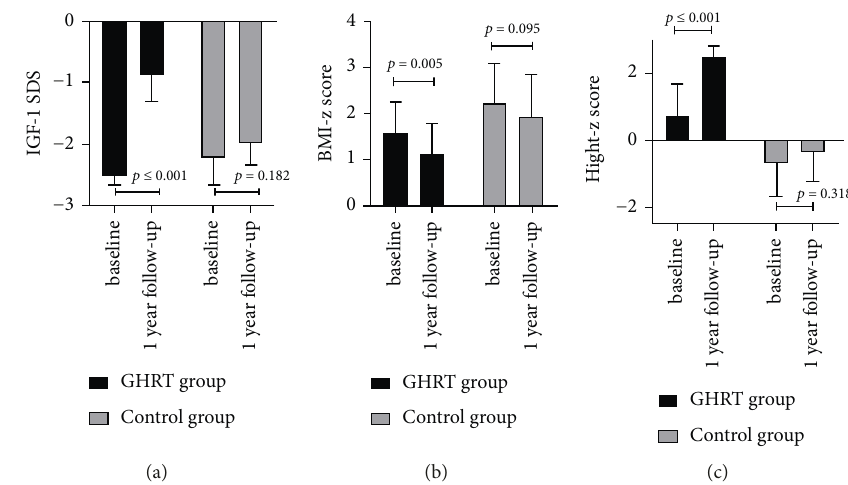
Figure 1: Flow chart of included patients.